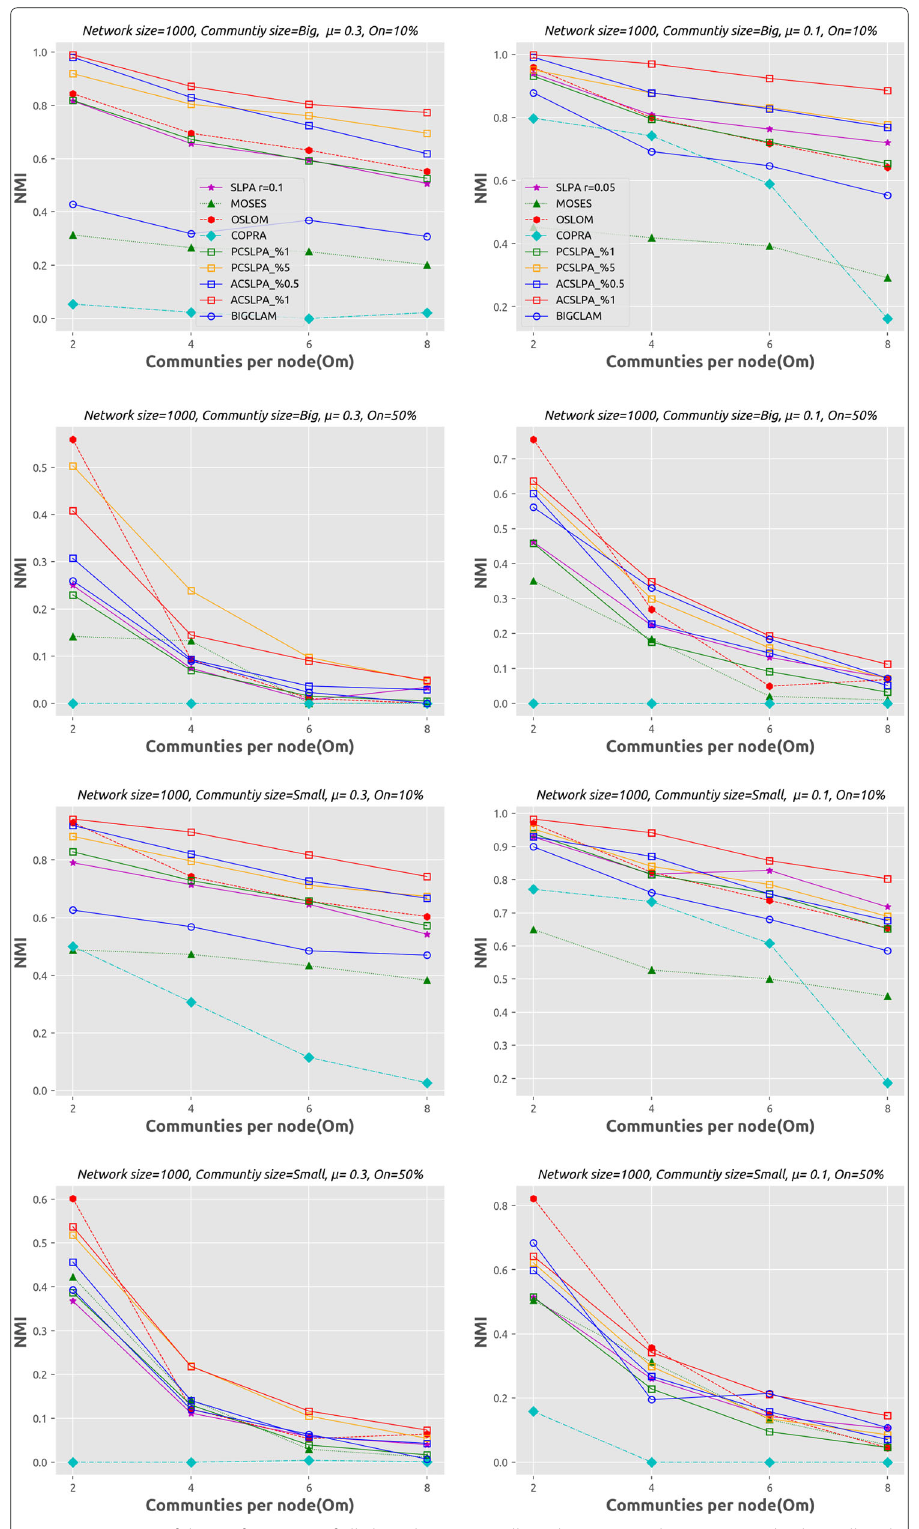
Fig. 4 Summary of the performance of all algorithms on small synthetic networks, containing both small and large communities, where the mixing parameter μ varies from 0.1 to 0.3. NMI values are plotted against the number of communities per node ( O m ) , with 4 networks in each